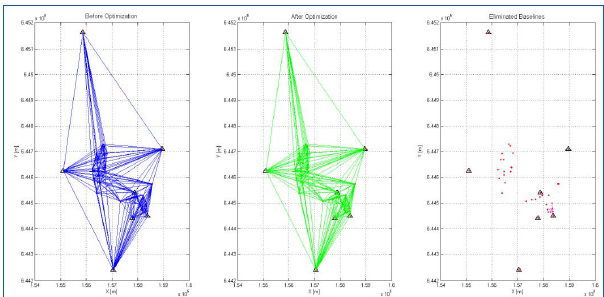
Figure 3: SOOM of reliability with precision constraint and sensitive to detect 5 mm displacement. The panels from left to right illus- trate the original network before optimisation, optimised one and removed baselines, respectively.